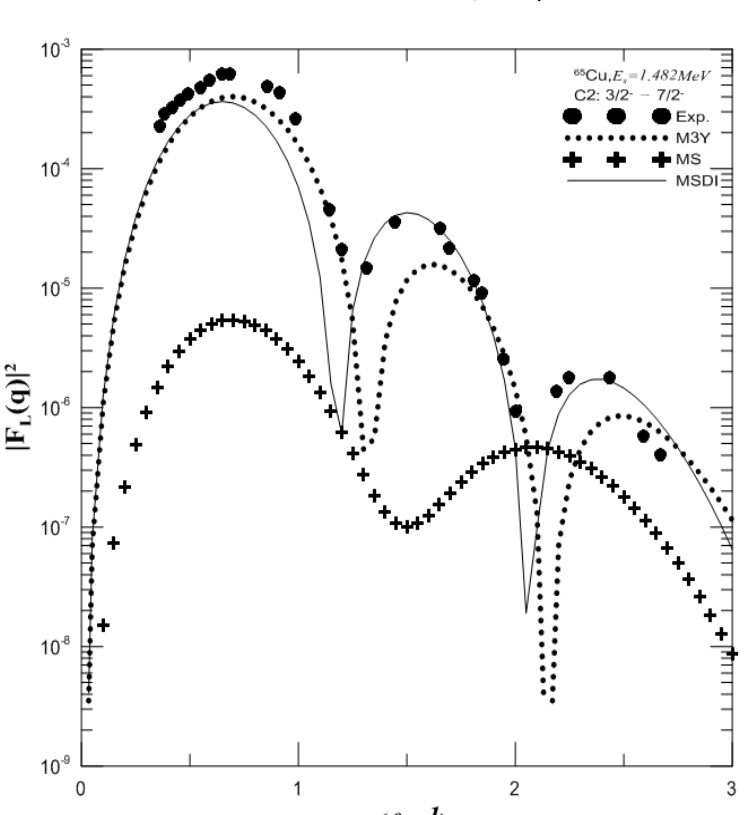
Fig.7: Inelastic longitudinal form factors for C2 transition 3/2 -  7/2 - in 65 Cu nucleus using MSDI and M3Y interactions with core-polarization effects, through particle-hole excitations up to 6ћω. The experimental data are taken from Ref.